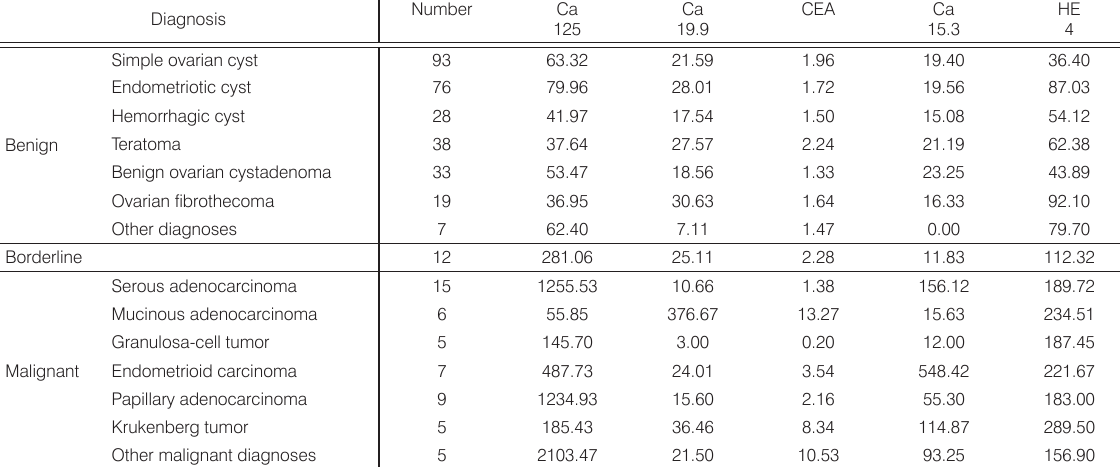
Table 1. Mean levels of serum tumor markers in histopathological findings of adnexal